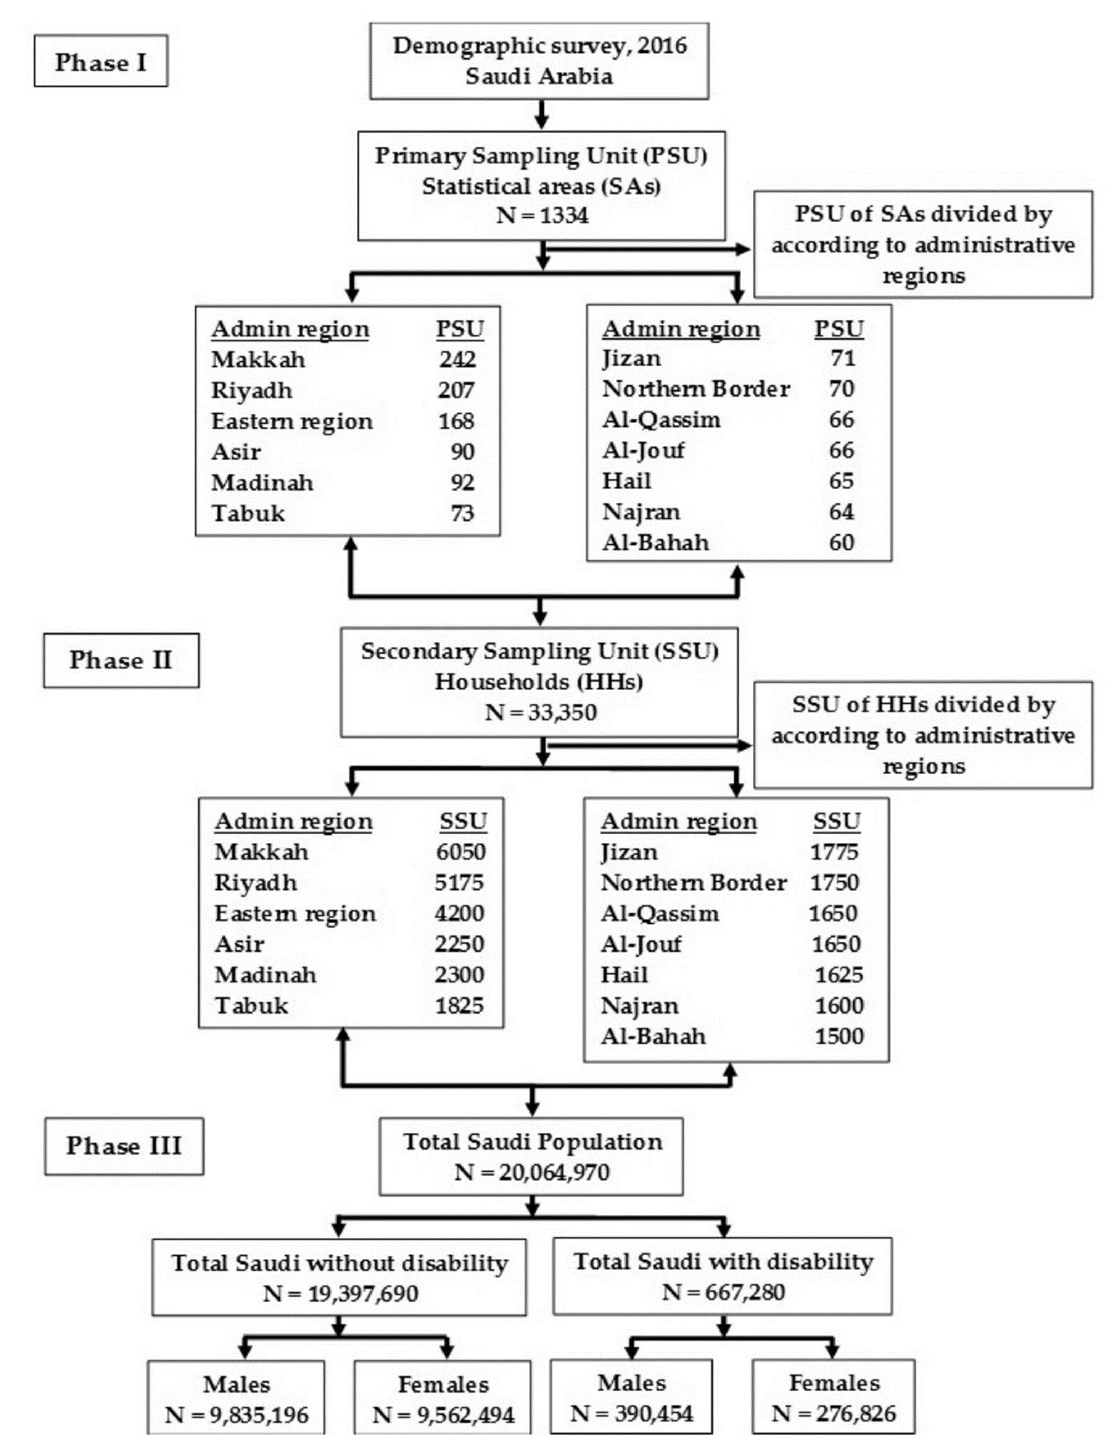
Figure 1. The flow of demographic survey sample selection in 2016.